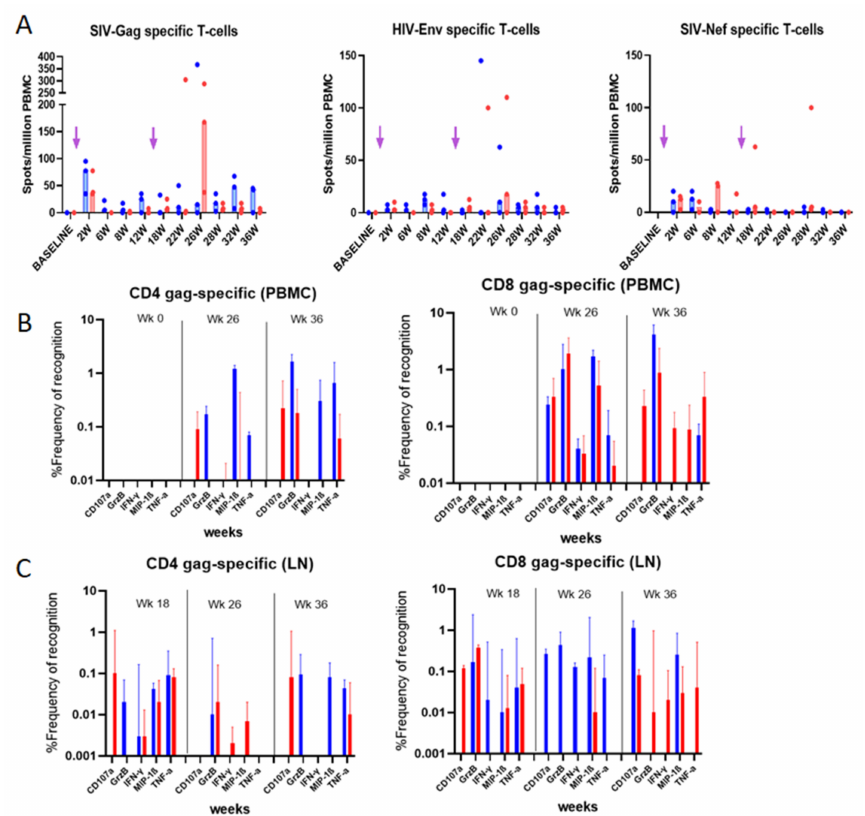
Figure 4. Vaccine-specific T-cell responses in blood and LN mononuclear cells from immunized rhesus macaques: ( A ) IFN- γ ELISpot responses to Gag, Env and Nef following overnight stimulation. Unstimulated cells were used as negative control for normalization. Median of the 3 animals per group is represented. Arrows indicate immunization times. ( B ) PBMCs and ( C ) LN mononuclear cells were used for the ICS assay using the panel of Ab reported in Table 2. Frequencies of Gag-specific cells measured at indicated time points are reported. Median values with 95% CI of the proportion of cytokine-secreting cells are shown. CAL-SHIV-IN − group is presented in blue, and CAL-SHIV-IN − IRES-rmIL-7 + CAL-SHIV-IN − IRES-rmIL-15 in